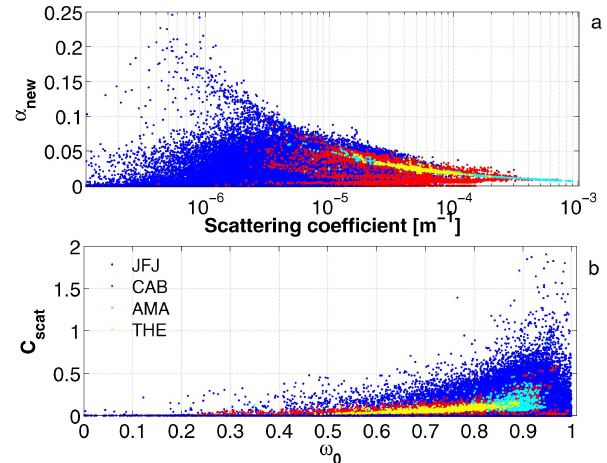
Fig. 6. Dependence (a) α new at λ =660nm as a function of scat- tering coefficient at λ =550nm and (b) C scat as a function of ω 0 at λ =660nm for the four datasets. α new and C scat , were calculated with the new correction scheme and represent the multiplying factor of the scattering correction (Eq. 14a), and the scattering correction in Schmid method (Eq. 14b),